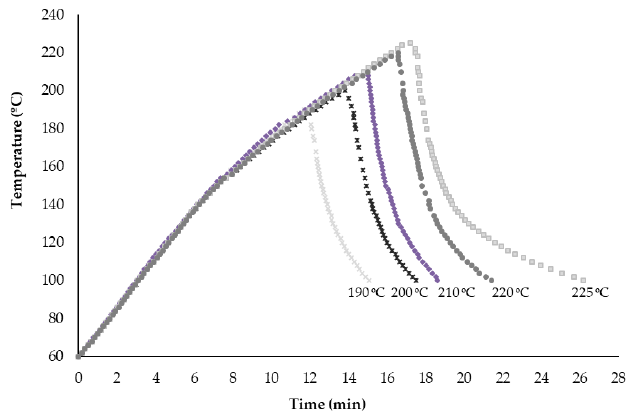
Figure 1. Heating and cooling profiles obtained for the autohydrolysis experiments performed at the assayed